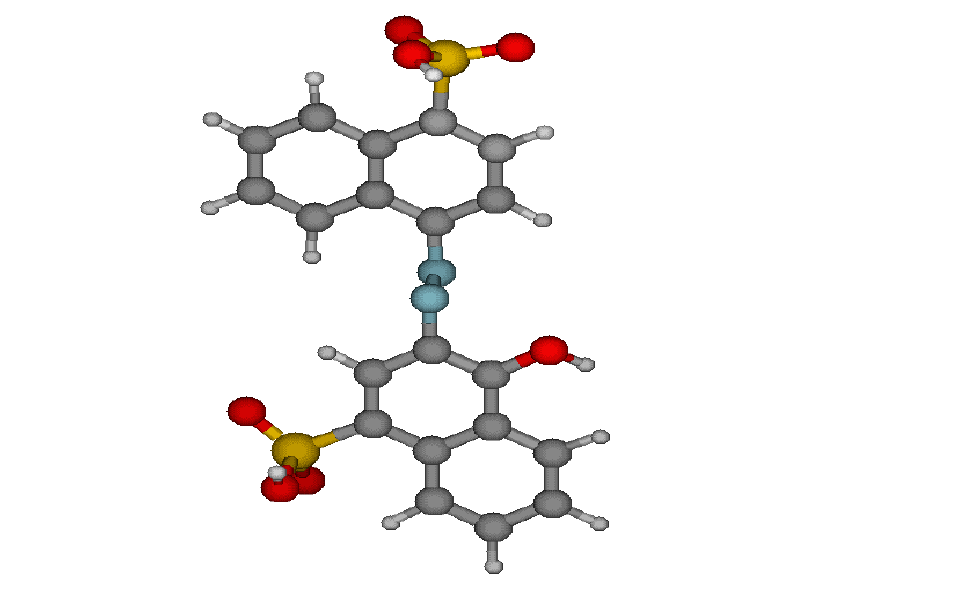
12 Table 6. Table showing Allura Red detection using carbon paste electrodes with different modifiers along with their de- tection limits. S.No. [41] 2.6. Detection of Carmoisine (CR) Carmoisine (Figure 11) synthetic azo dye is widely used in the food industry, having two naphthalene units. It offers a color range from red to maroon with typical applications